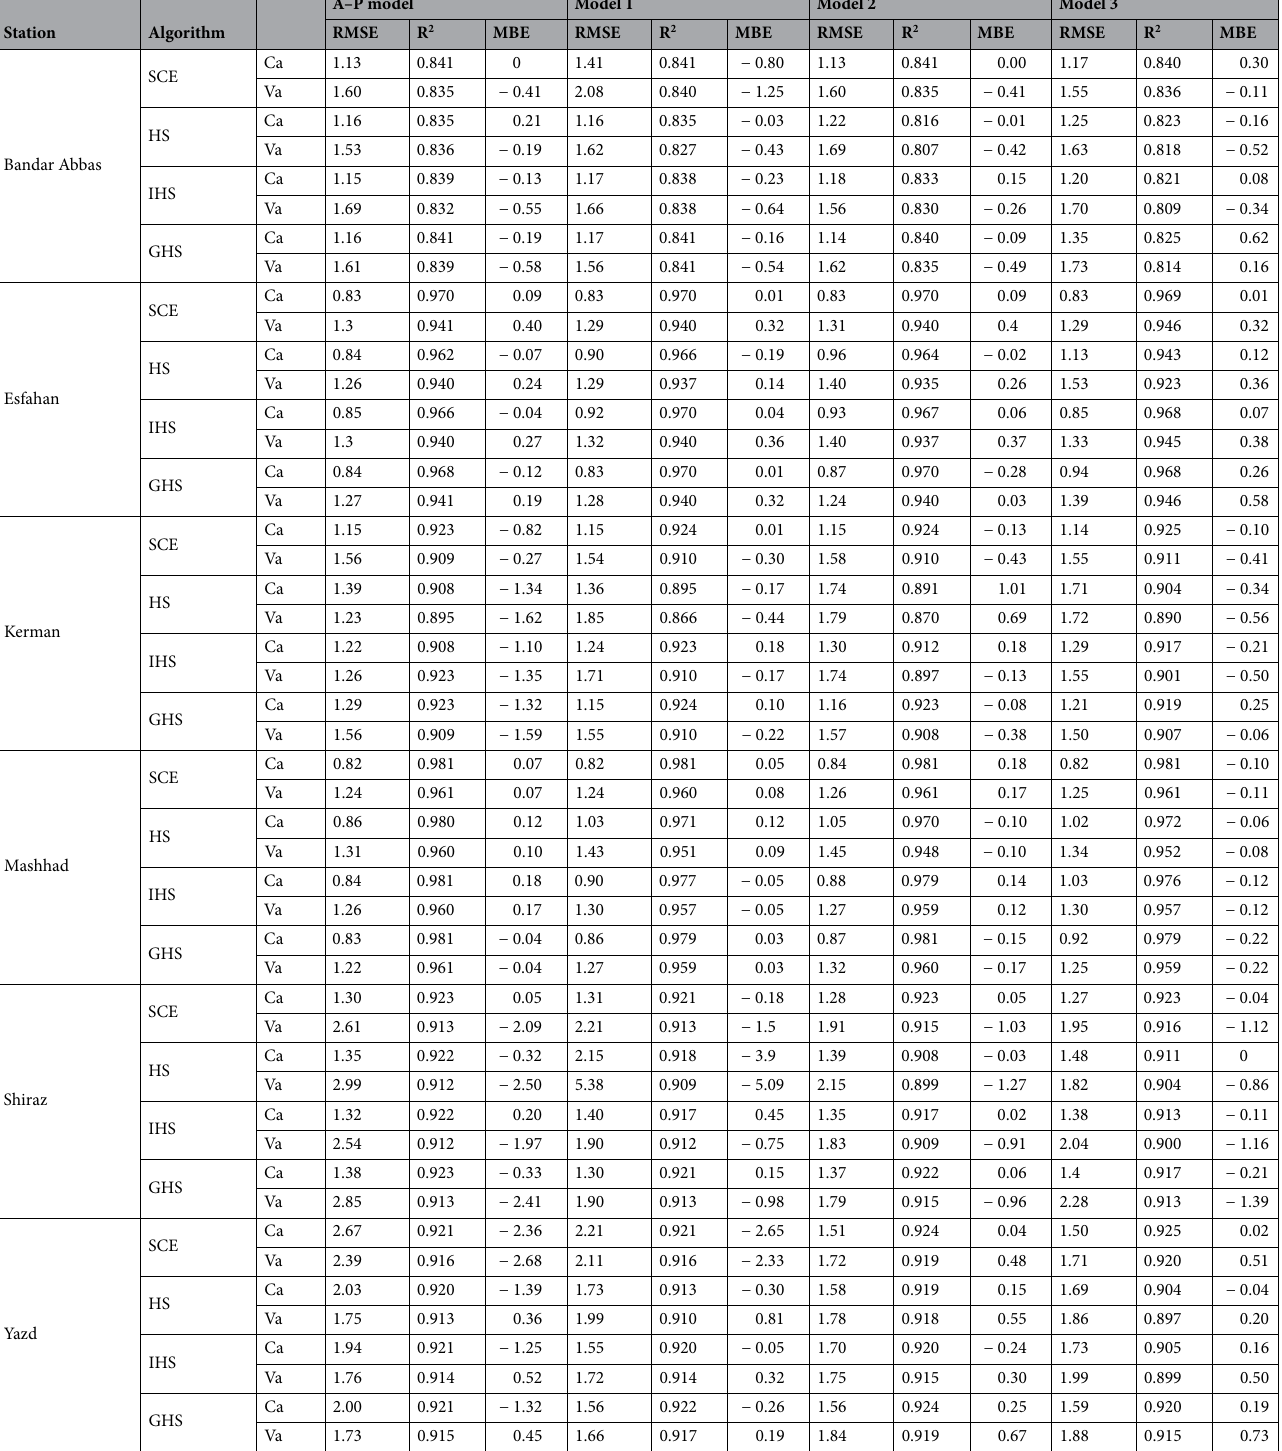
Table 5. Statistical comparison of calibration (Ca) and validation (Va) estimated R s (using the locally calibrated of the models coefficients). RMSE (MJ m −2 day −1 ), MBE (MJ m −2 day −1